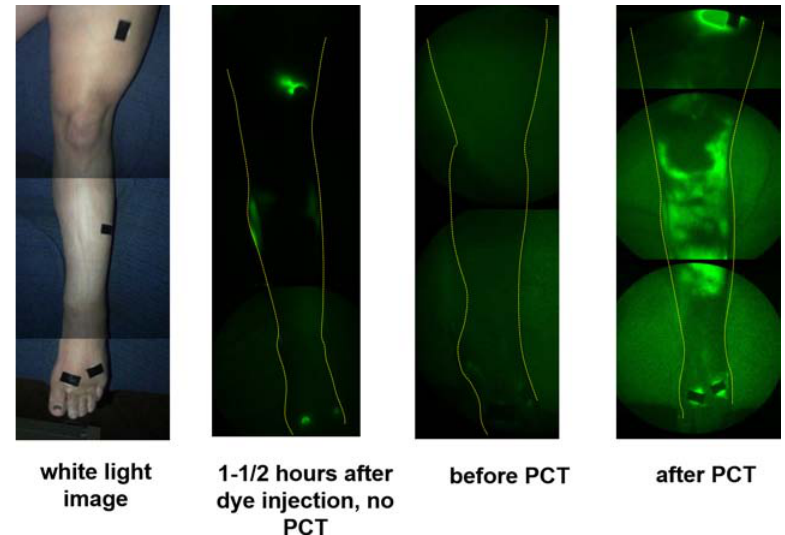
Note : Full-leg images are montages of smaller regional images. Fig. 5. Fluorescent dye/lymph distribution in left posterior leg before and after PCT in subject 1. (leftmost) white light image, (second from left) NIRFLI image 1 – 1/2 – 2 h after dye injection, from ¯rst NIRFLI imaging session, in which no PCT was performed, 18 months prior to second imaging session, (third from left) NIRFLI image before PCT in second imaging session, (rightmost) NIRFLI image after PCT in second session (1 – 1/2 – 2 hours after dye injection).